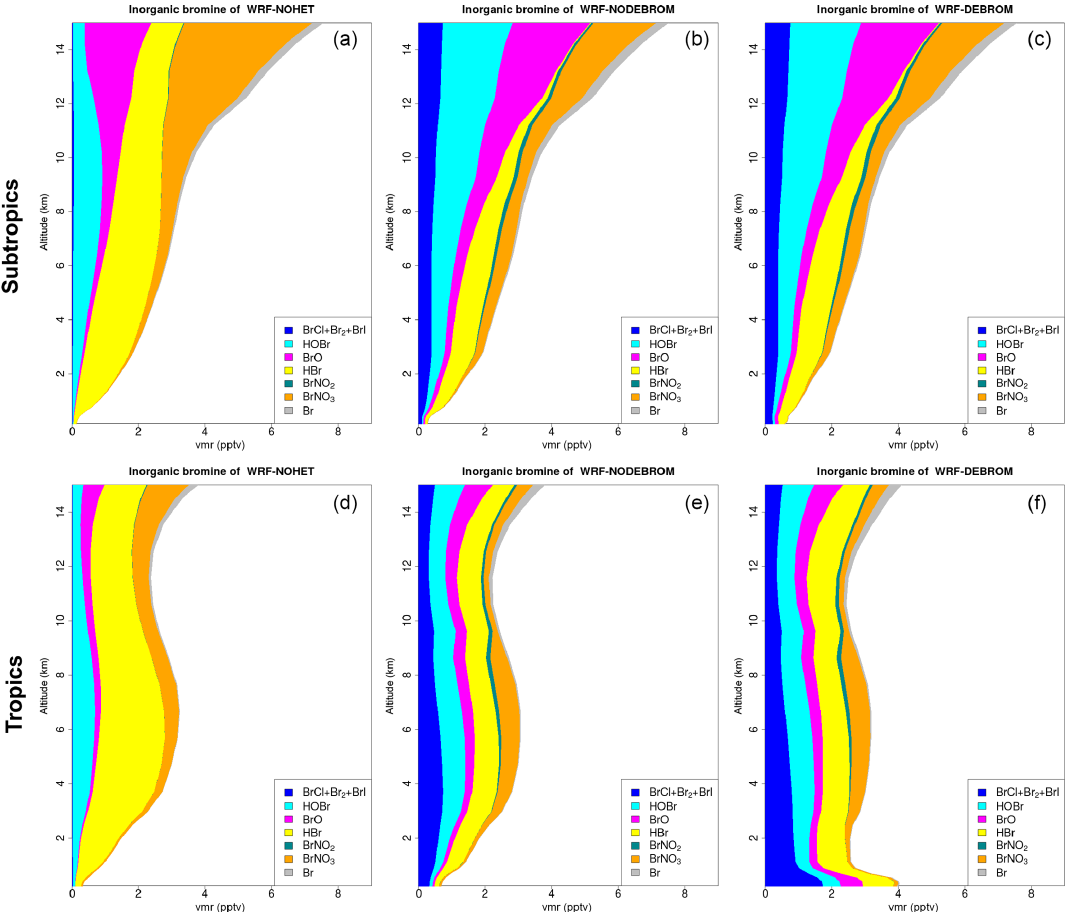
Figure 8. Regional average vertical partitioning of inorganic bromine (Br y ) for the three different simulations – WRF-NOHET (a, d) , WRF- NODEBROM (b, e) and WRF-DEBROM (c, f) – during January and February 2012. Panels (a, b, c) are over the subtropical area and panels (d, e, f) over the tropical. Units are in